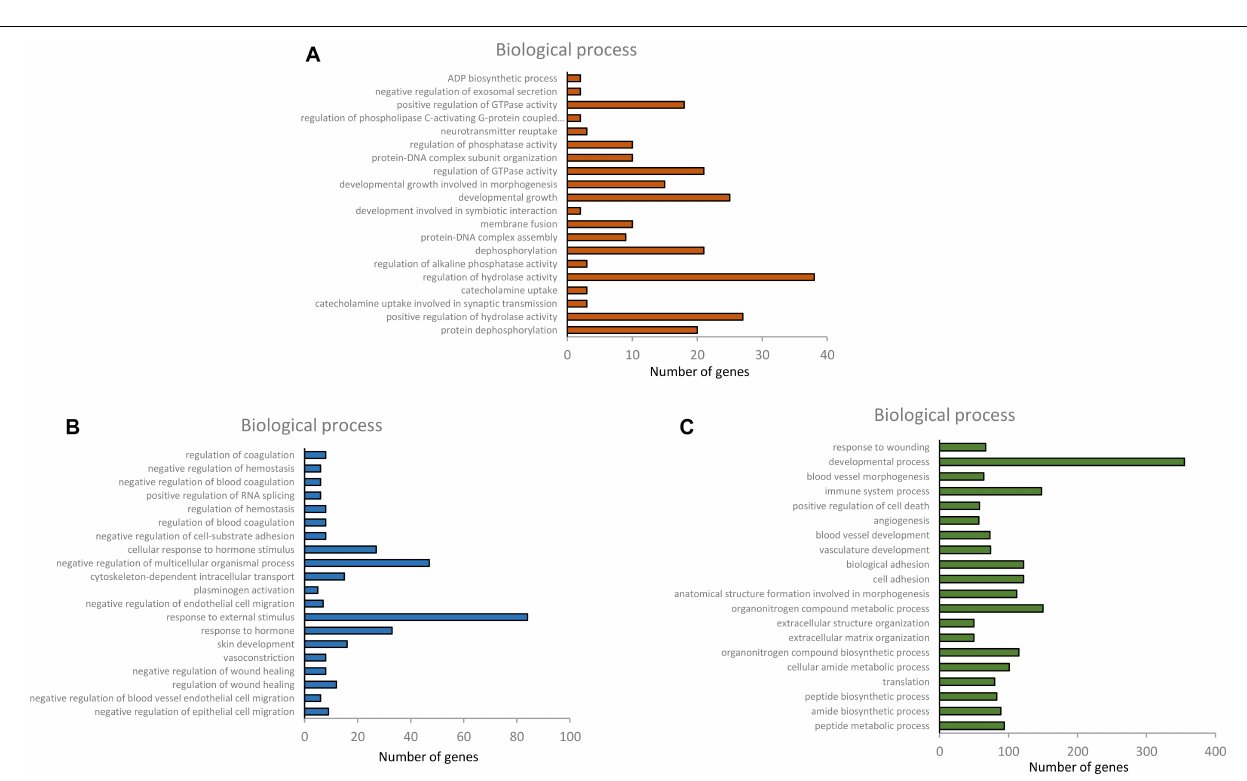
Frontiers in Genetics |